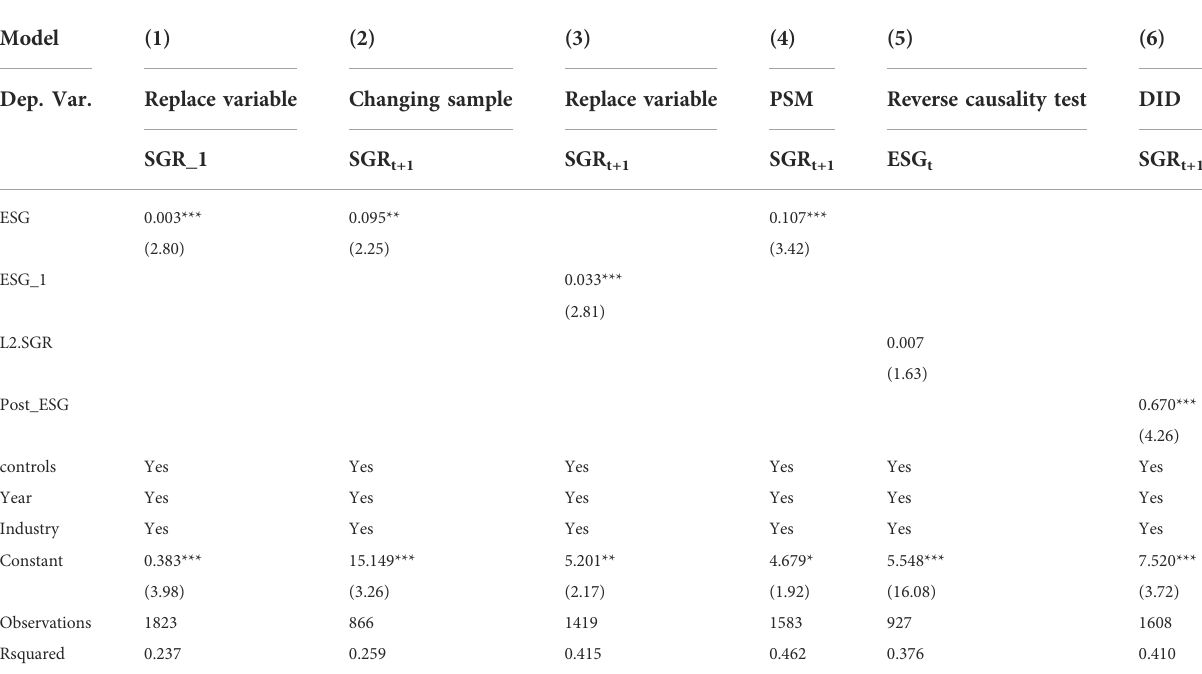
TABLE 6 Robustness